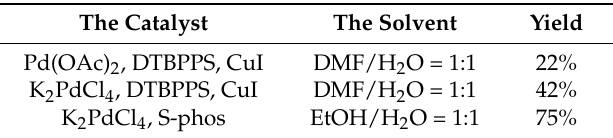
Table 2. The effect of catalyst systems in the Sonogashira